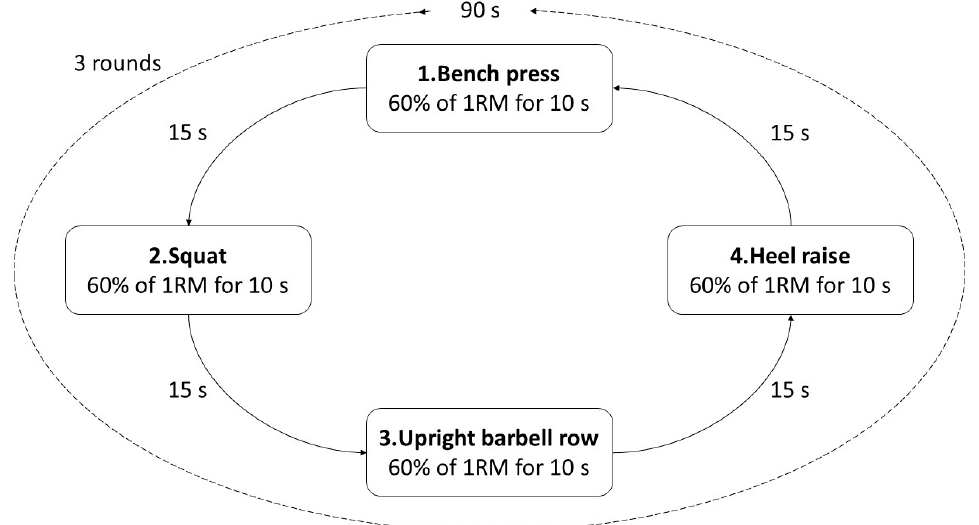
Figure 1. HIPT protocol.